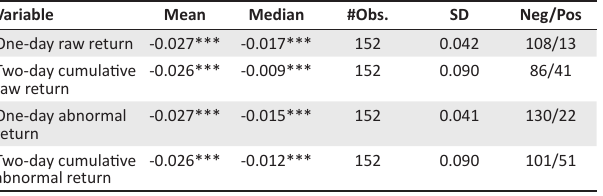
TABLE 3: The stock market’s reaction to secondary equity offering announcements. Variable